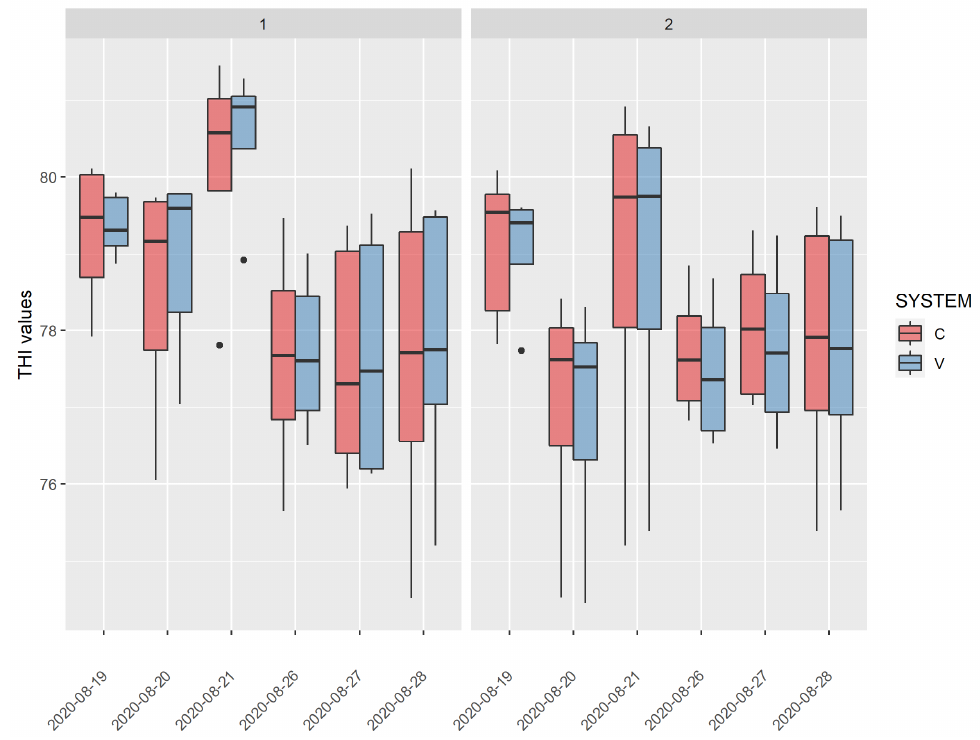
Figure 2. THI index distribution during the study period within the farms (1 and 2) and treatment (C and V).